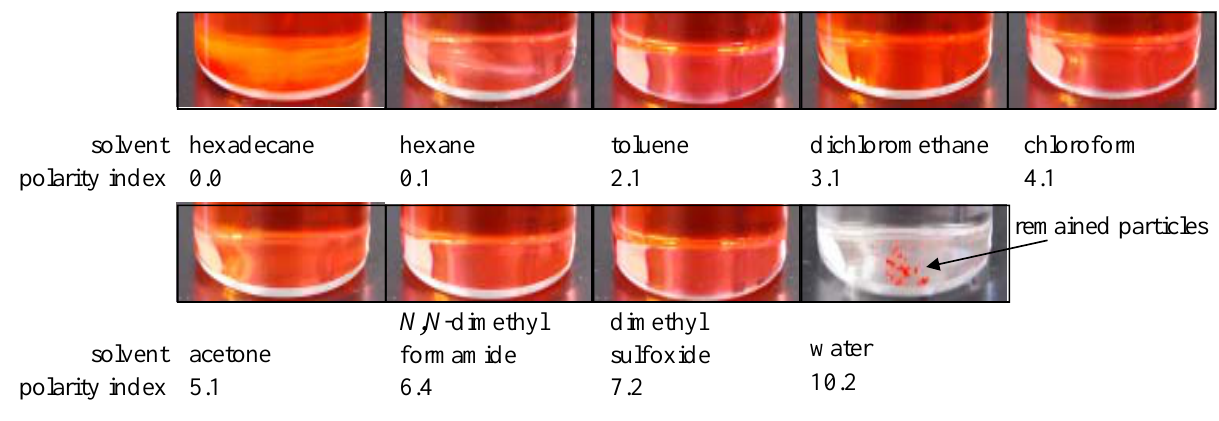
Figure 4. Pictures of solvent study with PtTFPP as a luminophore. Nine different solvents were selected by their polarity index.